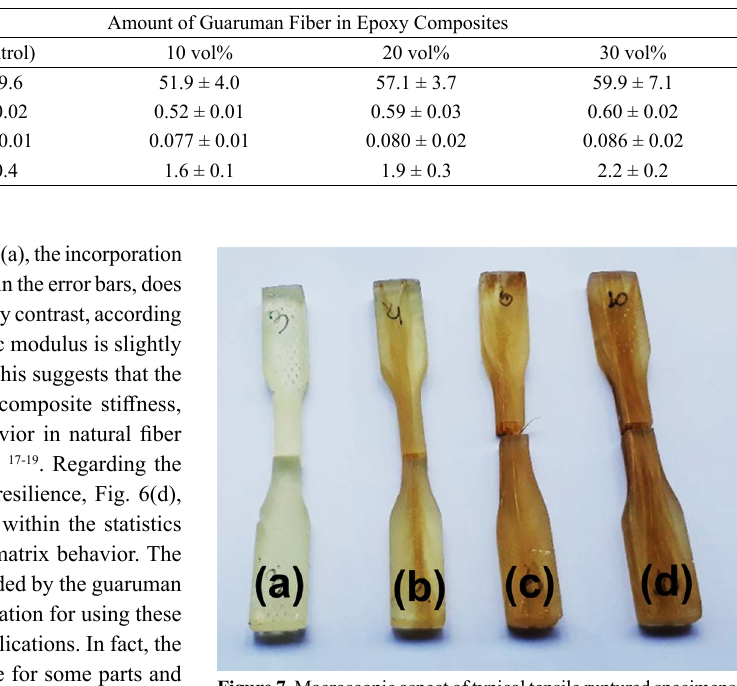
Figure 7. Macroscopic aspect of typical tensile ruptured specimens: (a) plain epoxy; (b) 10 vol% guaruman fiber; (c) 20 vol% guaruman fiber; and (d) 30 vol% guaruman fiber reinforced epoxy